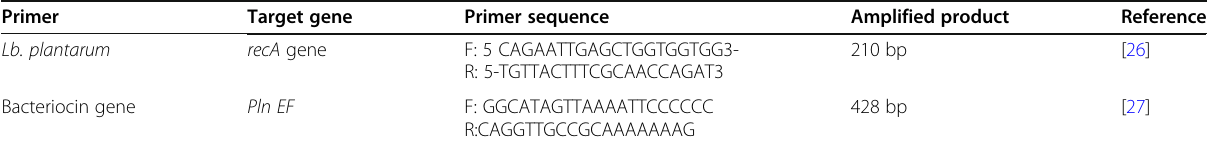
Table 1 Specific oligonucleotide primers sequences (Metabion; Germany)